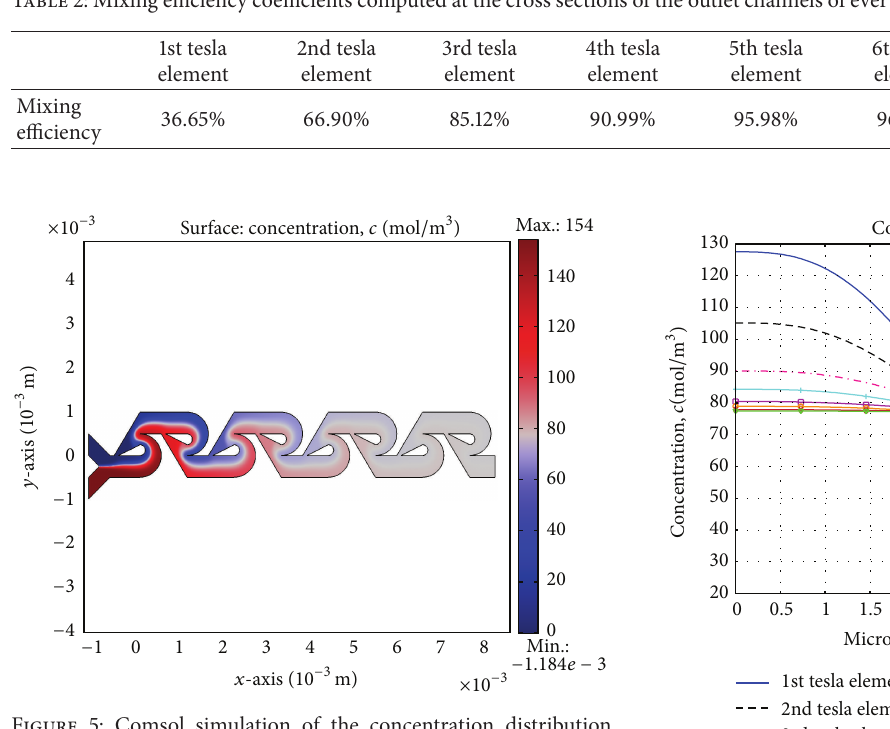
Figure 5: Comsol simulation of the concentration distribution along a micromixer with 8 connected tesla elements [13].